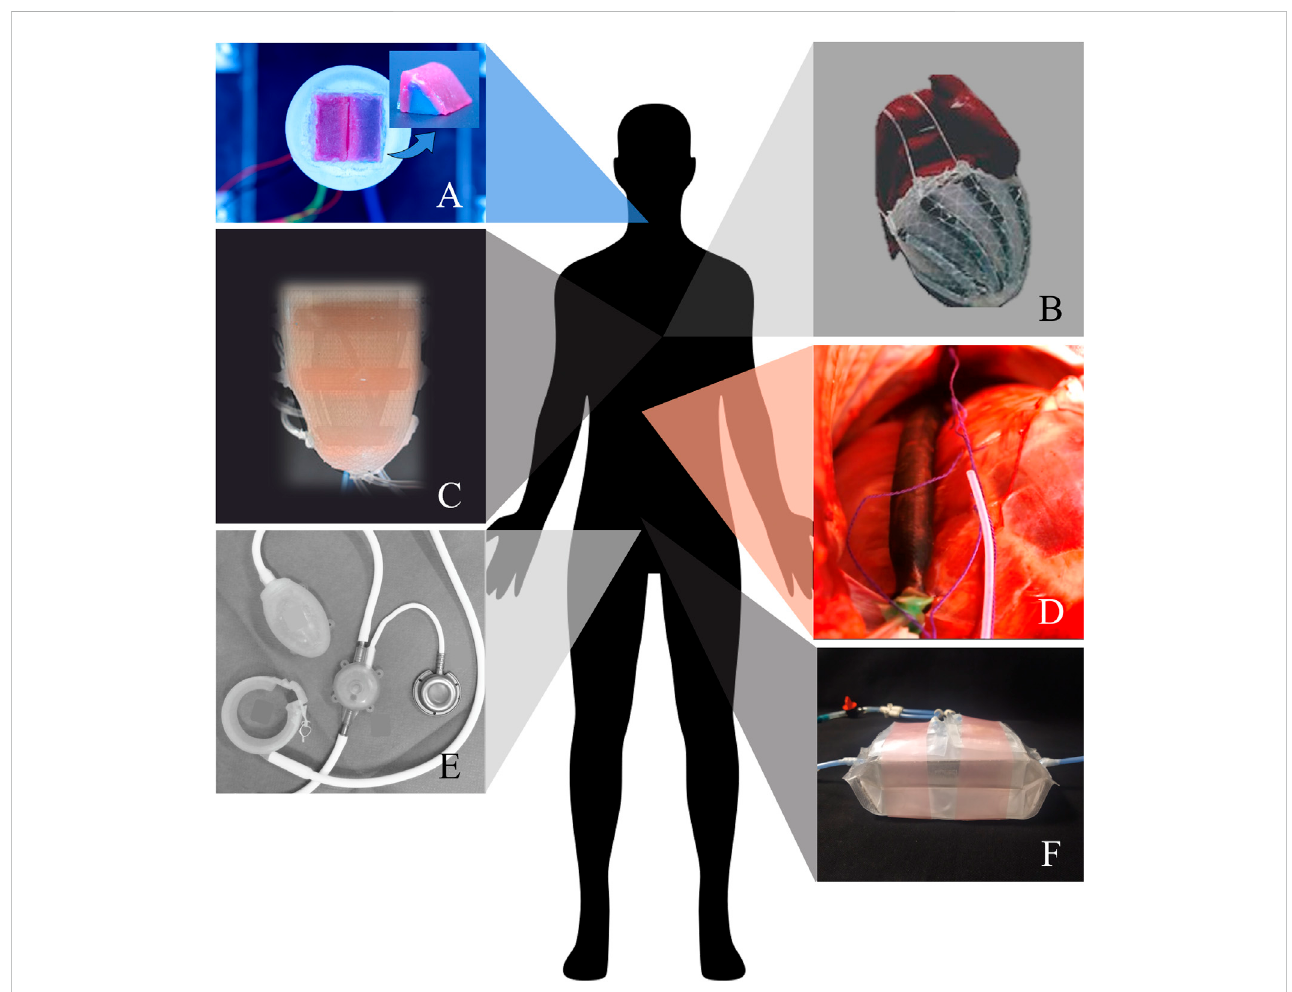
FIGURE 2 (A) Synthetic vocal folds simulator (courtesy of Dr Martina Maselli, Scuola Superiore Sant ’ Anna, Italy); (B) Soft robotic sleeve, pneumatically actuated by McKibben arti fi cial muscles (republished from Park et al. (2022)); (C) Soft robotic left ventricle prototype, pneumatically actuated by a dual-layer of fl attened and cylindrical McKibben actuators (republished from Park et al. (2022)); (D) Soft robotic arti fi cial ventilator: a close-up on a supradiaphragmatic McKibben actuatorplacedontherighthemidiaphragmofan invivo porcinemodel(republishedfromHuetal.,2021); (E)